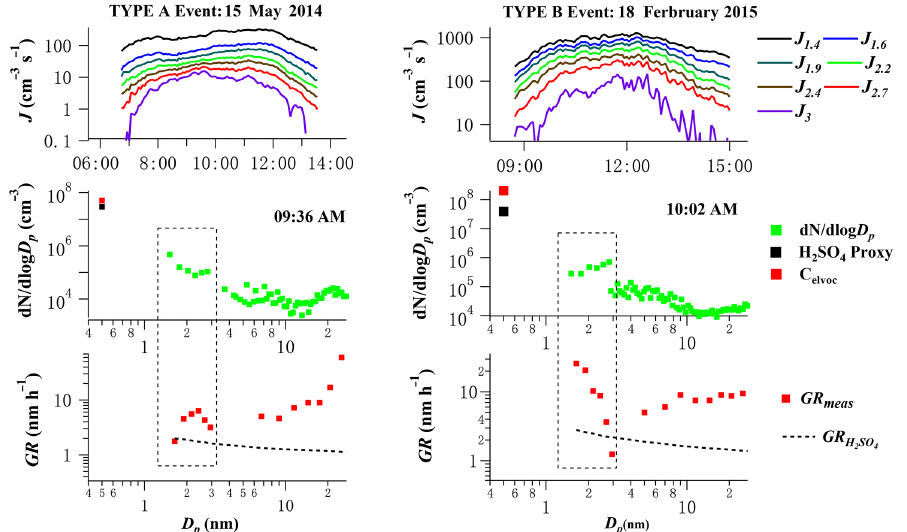
Figure 6. Upper: formation rates (or equivalently, particle growth fluxes) of 1.4, 1.6, 1.9, 2.2, 2.4, 2.7, and 3.0nm cluster/particles on 15 May 2014 (Type A1 event) and 18 February 2015 (Type B1 event). Middle: particle size distribution (d N/ dlog D p , green square) selected during the two events (09:36 and 10:02LT). Lower: particle growth rates measured during the same time periods (GR meas , red square). Also shown in the figure were H 2 SO 4 proxy (black square) and growth rates calculated from the H 2 SO 4 proxy (GR H as the calculated ELVOC concentration ( C elvoc , red square, see Eq. 5) during the same time periods. Dashed boxes in the lower panels highlighted the size distributions and growth rates between 1.4 and 3nm measured with